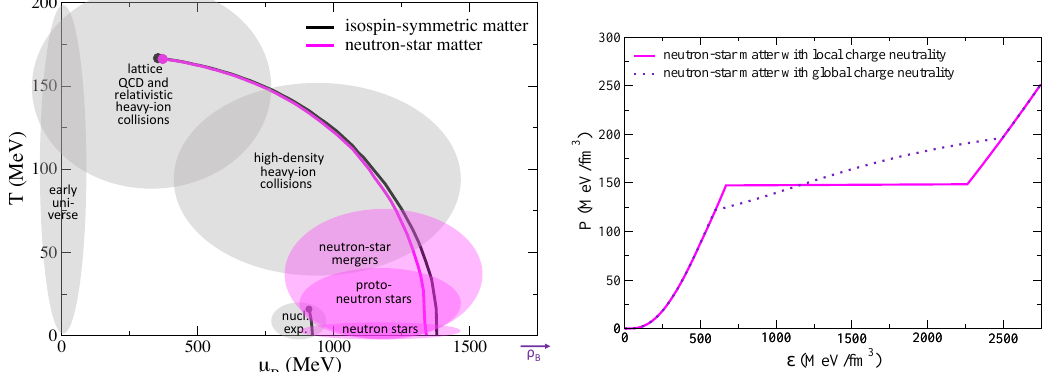
Figure 4. Left : QCD Phase diagram resulting from the CMF model. The lines represent first-order transitions. The circles mark the critical end-points. Isospin-symmetric matter refers to zero isospin and strangeness constraints, while neutron-star matter stands for charged neutral matter in chemical equilibrium. The shaded regions exemplify some of the different regimes that can be described within the model. Right : EoS for star matter at T = 0 under different charge neutrality conditions calculated with the CMF